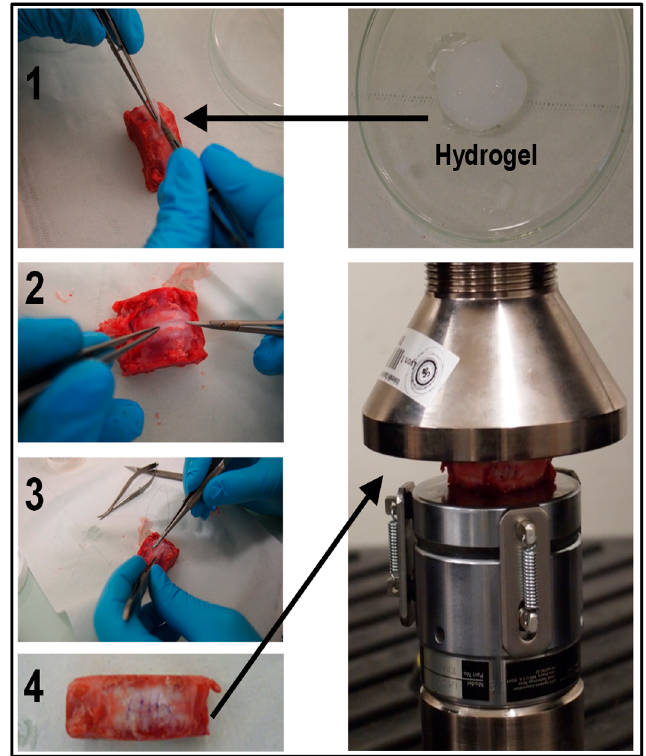
Figure 2. Implantation of the CNF/CHI composite hydrogel shown in the top-right (3% CHI/0.4% CNF ( w / w )) in an annulus fibrosus tissue defect ( 1 , 2 ) of a L4–L5 lumbar disc of a pig model (Figure 1). The disc was sutured at the implanted position ( 3 , 4 ) and subjected to compression loading as shown in the bottom-right of the figure.